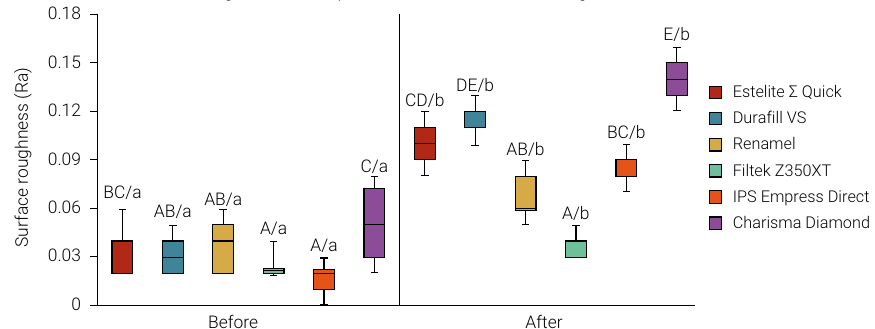
Figure 1. Box plots of surface roughness values (Ra: (cid:80) m) of resin composites before and after the challenges. Different uppercase letters represent statistical significance among composites (p<0.05). Different lowercase letters indicate statistical significance before and after challenges (p<0.05).